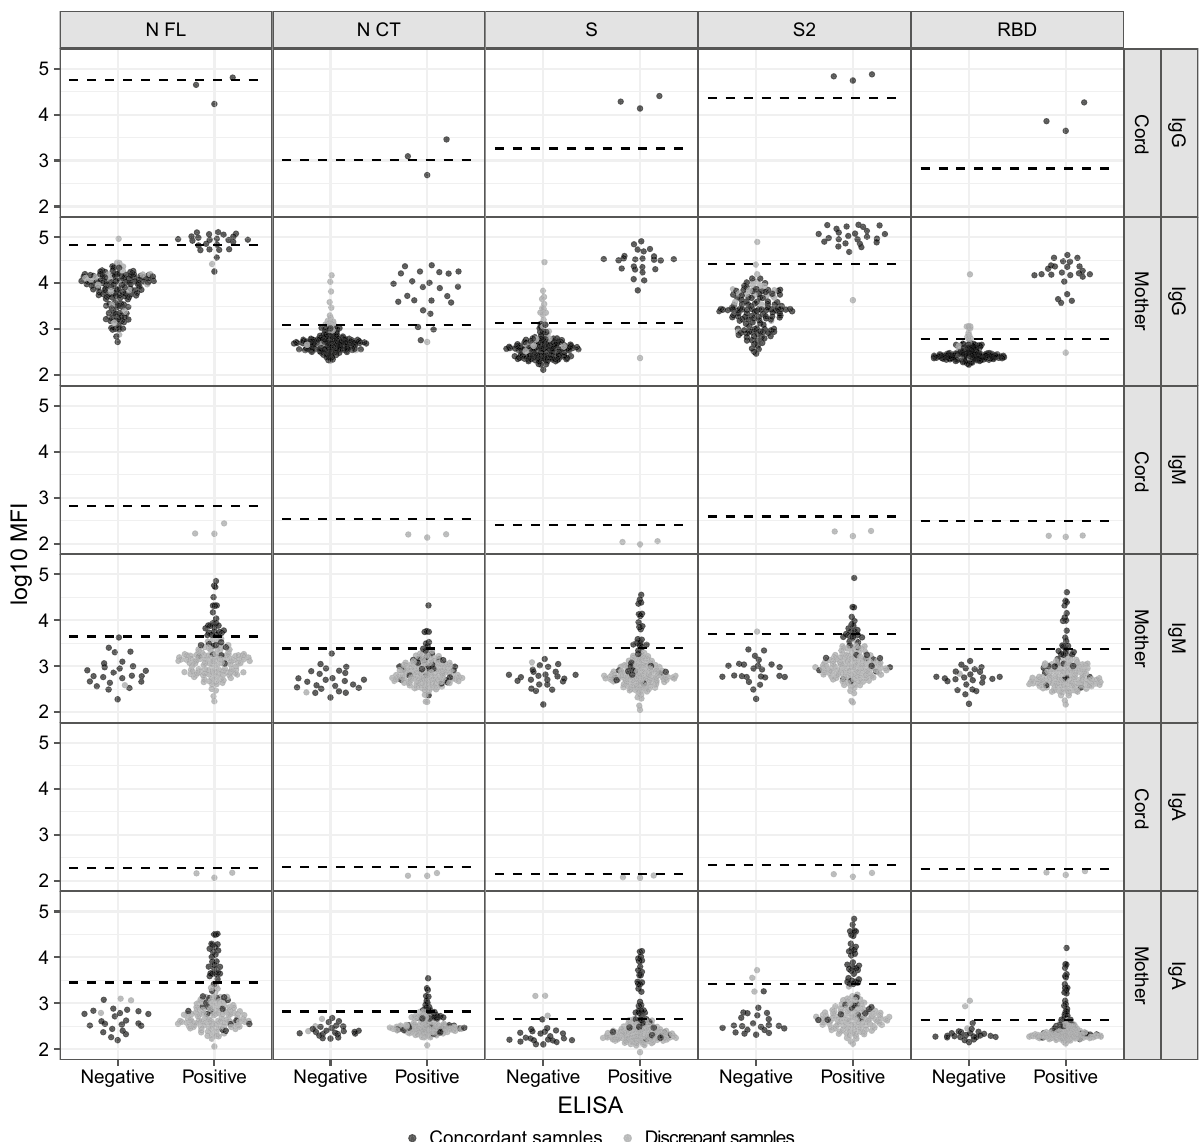
Figure 1. Classification of samples by ELISA and Luminex immunoassays for specific IgG, IgM and IgA. The categories in the X-axis refer to the classification of the ELISA assay (negative or positive). The Y-axis indicates the Luminex assay result in log10-transformed median fluorescence intensity (MFI). The seropositivity cutoff is shown in dashed lines (mean plus 3 SD of prepandemic samples). The color classification in concordant (black) versus discordant (grey) sample results between Luminex and ELISA tests is based on the combination of all antigens within each isotype for Luminex. That is, seropositivity and seronegativity were calculated per each immunoglobulin with the combination of all antigens from the Luminex assay, and those were compared with the ELISA result to subsequently define concordant and discordant samples between tests. The figure illustrates the lower specificity of the ELISA assay for IgM/A (elevated number of false positives) compared to the Luminex IgA and IgM assays, and the higher sensitivity of the IgG Luminex for the detection of positive samples that had been classified as negative by